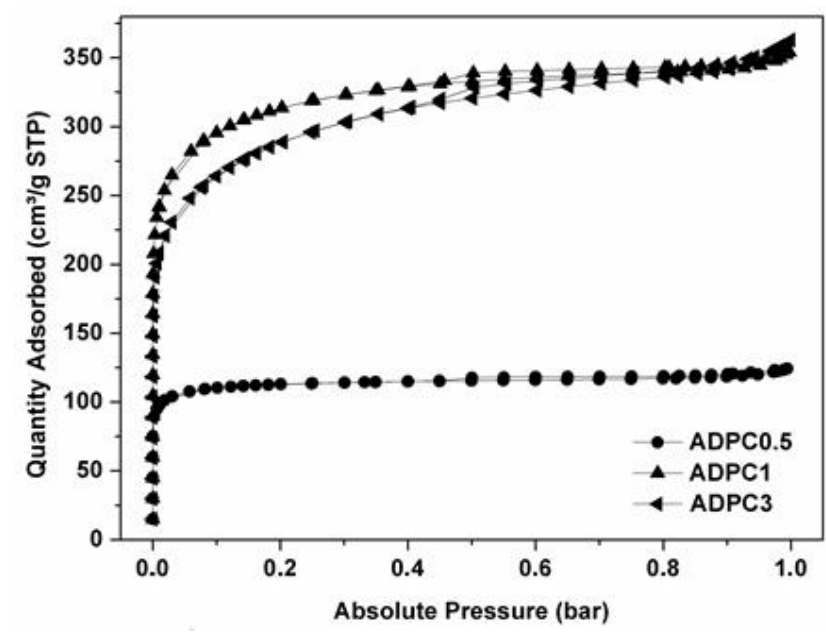
Figure 4. N 2 adsorption–desorption isotherms at 77 K.